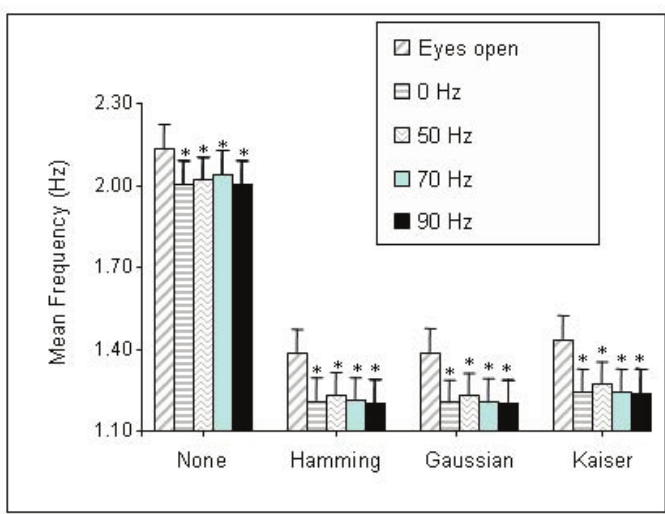
Figure 7. Mean frequency estimation using Fourier–Bessel Expansion for 100-point win- dows (AP): (a) No window; (b) Hamming window, (c) Gaussian window ( (cid:5) D 2:5 ), (d) Kaiser window ( ˇ D 8 ).